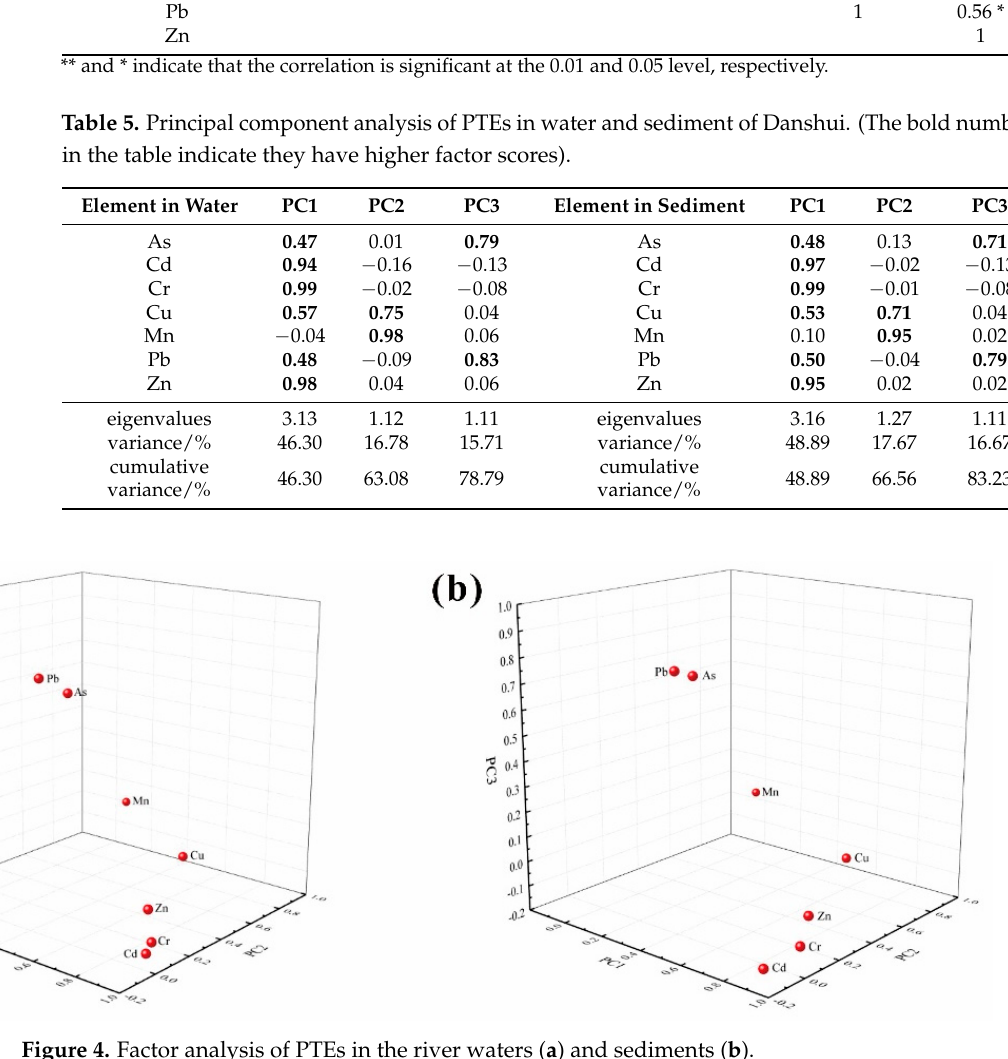
correlation with the elements of the first group (0.56 ≤ r ≤ 0.69, p < 0.05). At 0.05 significance level, the correlation coefficients of Cu with As, Cd, Cr, Pb, and Zn were 0.59, 0.64, 0.67, 0.61 and 0.69, respectively, and similar correlations also existed between Cu and Mn.